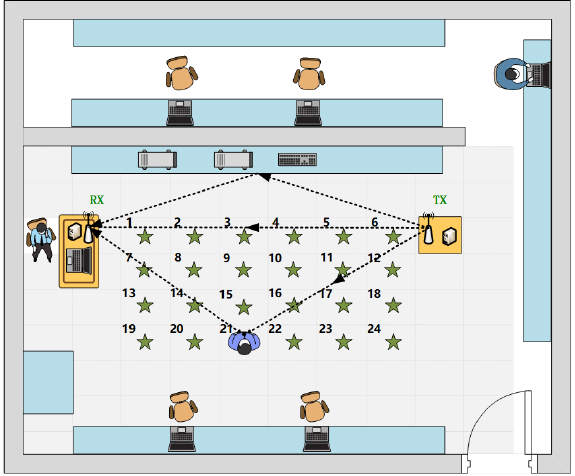
Figure 10. The layout of data collection